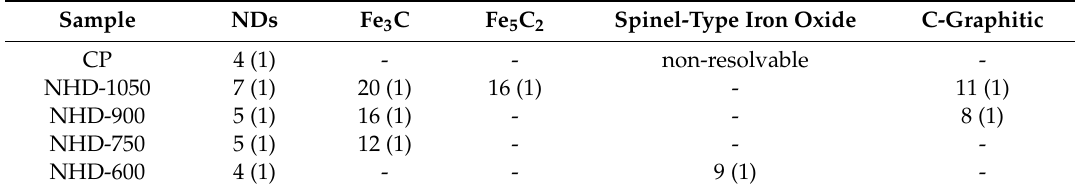
Table 1. Average NPs crystalline domain size < D > values, in nm, of the crystalline phases detected in the XRD diagrams of the samples as resulting using the Scherrer formula. The figures in parentheses denote the uncertainty attributed to the relevant last